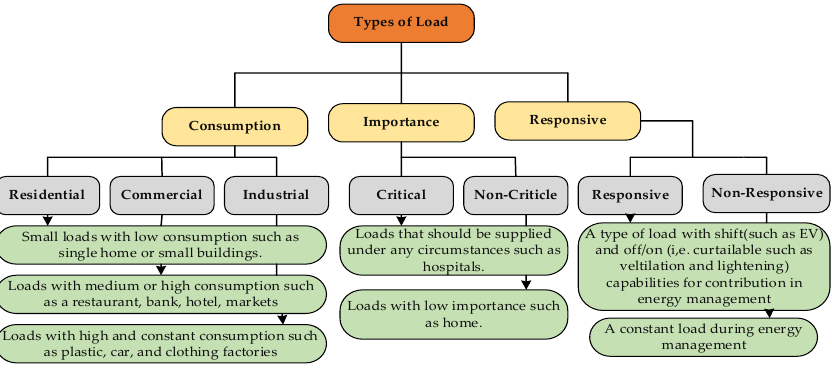
Figure 5. Types of loads.